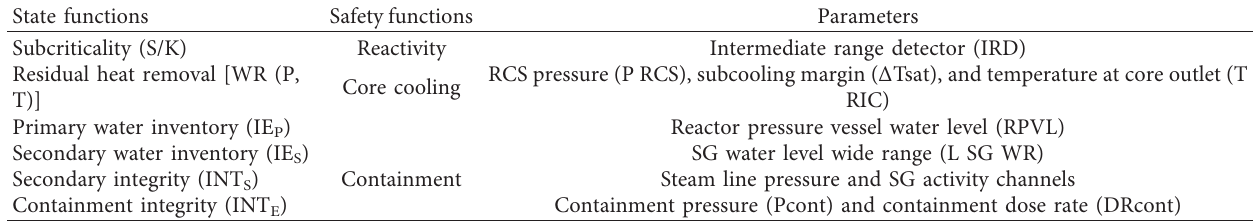
Table 1: State functions in SOP.